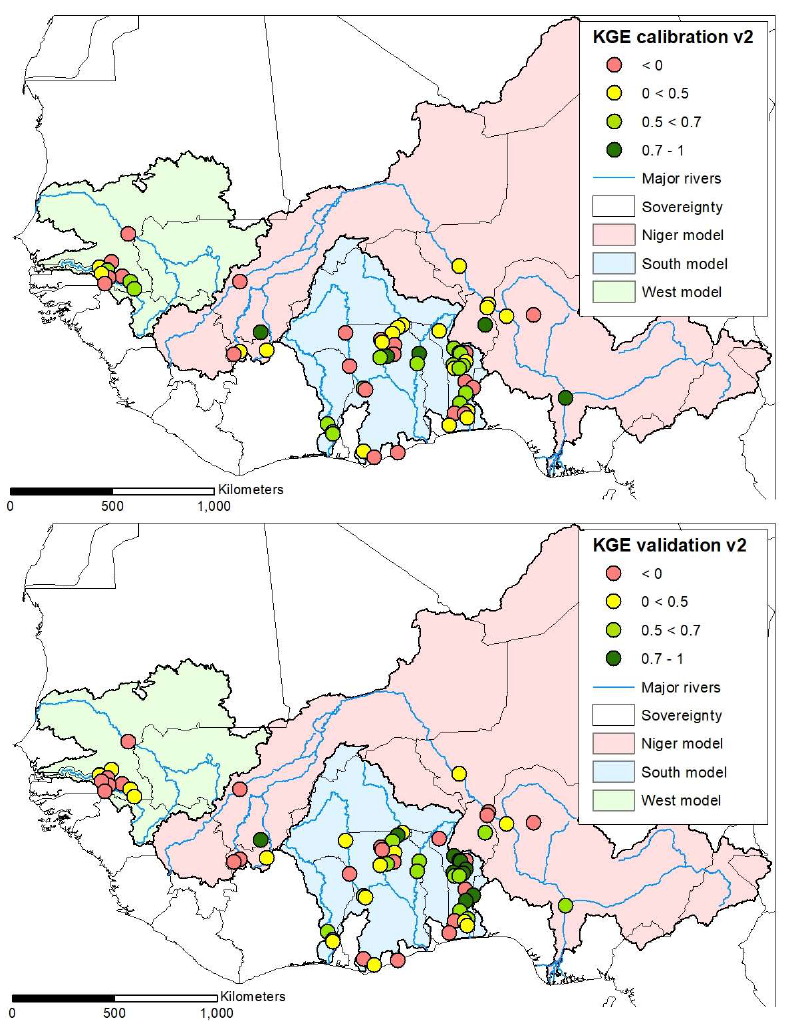
Figure 4. Calibration and Validation Results of the v2 (Local Calibration) Models.